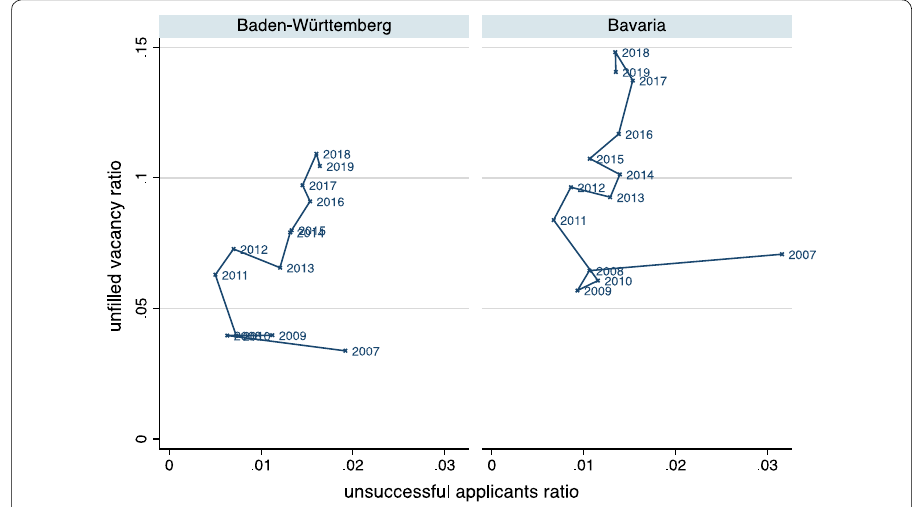
Fig. 8 Beveridge curves for South German states (2007–2019). Data sources: Vocational training statistics of the statistical offices of the federal and state